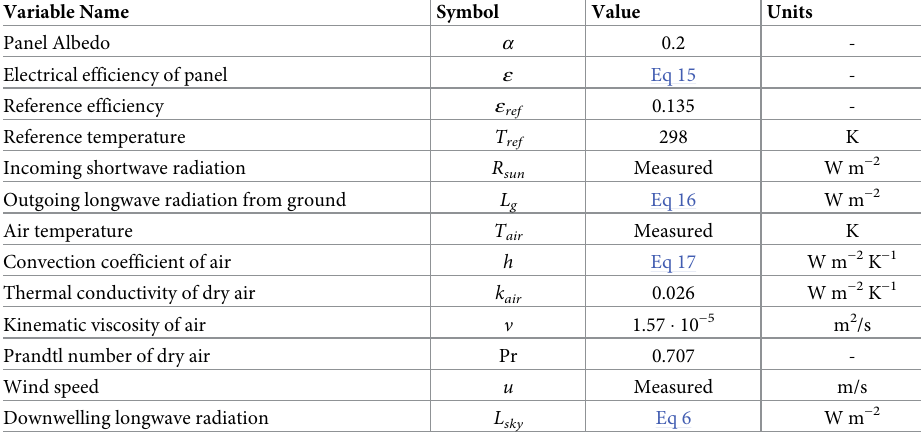
Table 3. Parameters for panel temperature